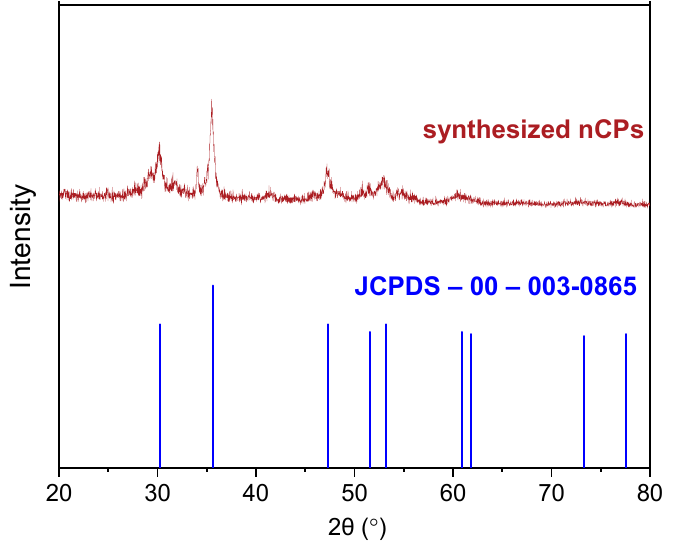
Figure 5. XRD spectra of CP and nCPs. Table 2. Comparison of 2 θ and d-spacing values of the standard CaO 2 with the synthesized nCPs. CaO 2 (JCPDS-00-003-0865) Peak Number